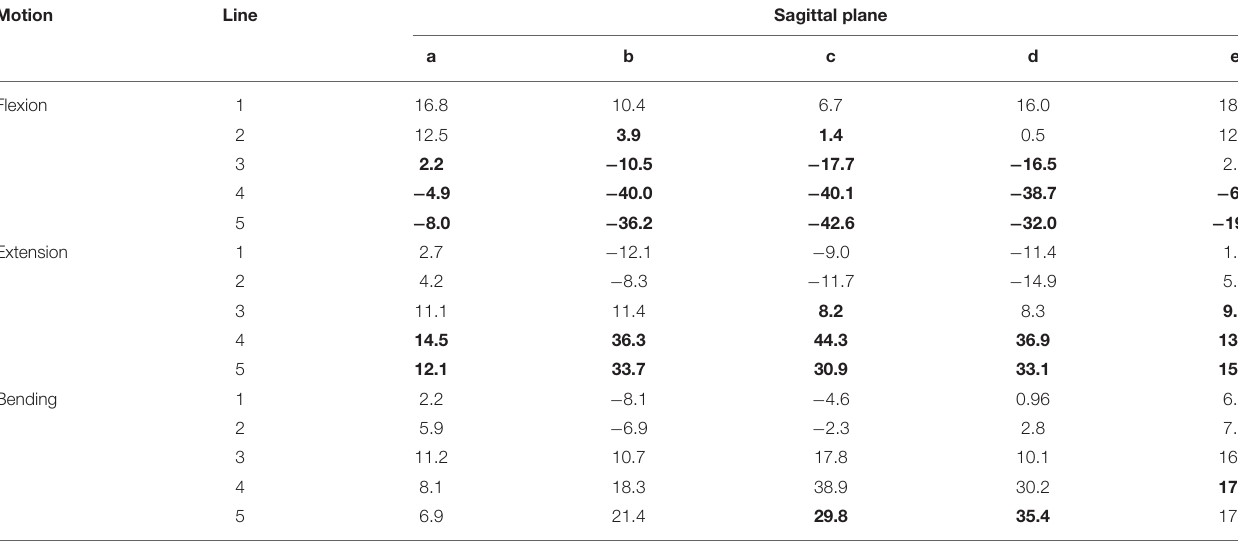
Significant changes are shown in bold. IVD, intervertebral disc.